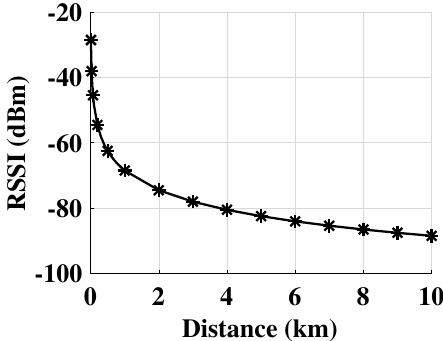
Figure 5. The received signal strength indicator with distance.